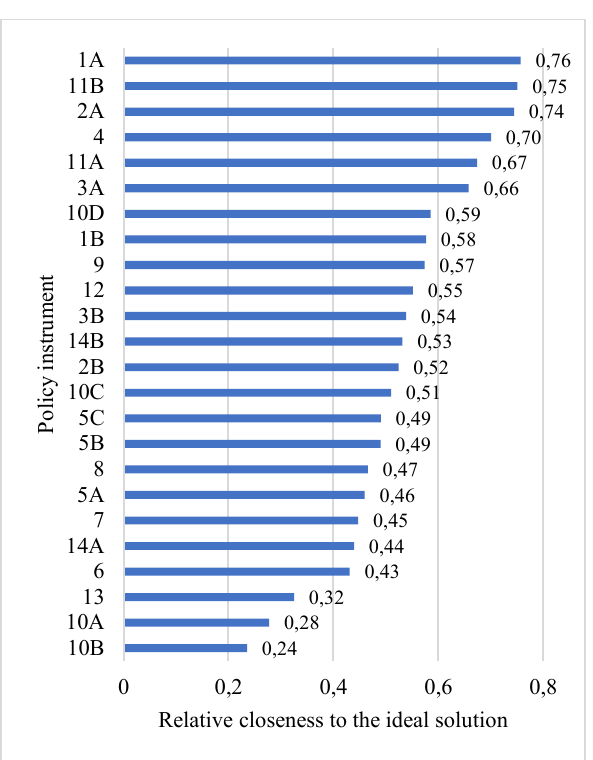
Figure 1. Relative closeness to the ideal solution of political